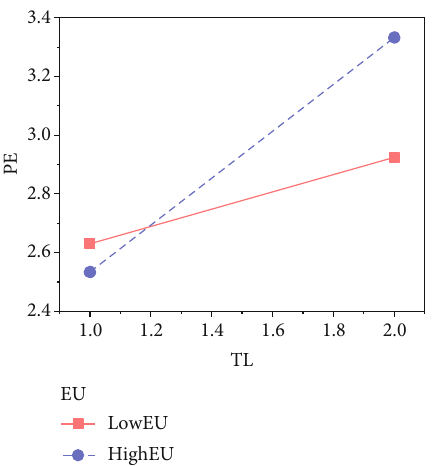
Figure 3: Numerical comparison of psychological empowerment mediation.